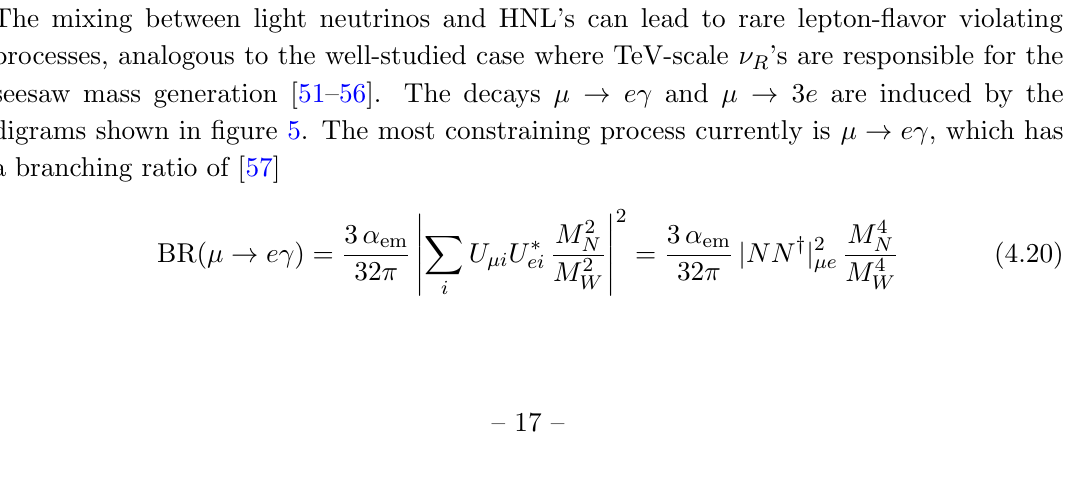
3 e from mixing of HNL’s with the light e(cid:13) and (cid:22) ! !